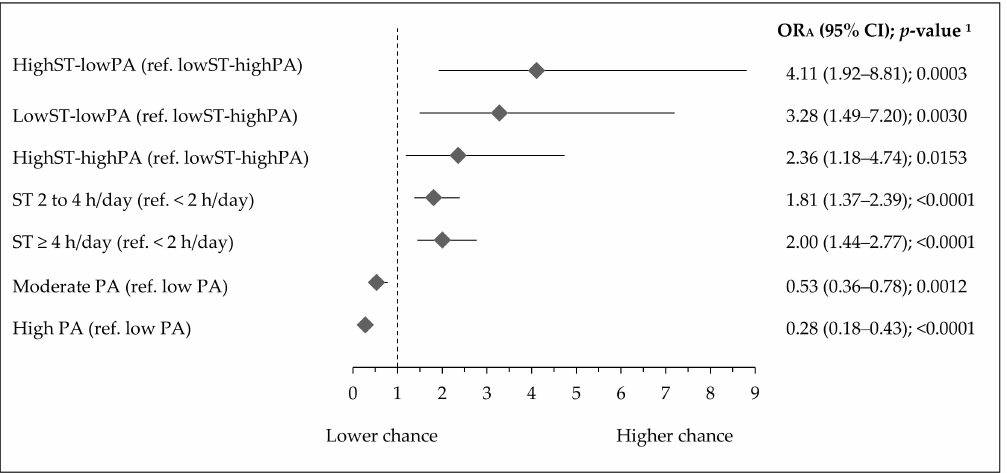
Figure 2. Association of activity–inactivity patterns, ST, and PA with overweight in Polish teenagers (ref. normal weight). Notes: ST—screen time; PA—physical activity; overweight and normal weight identified as gender-age-related-BMI according to international standards [35] as follows: overweight BMI ≥ 25 kg / m 2 , normal weight BMI = 18.5 to 24.9 kg / m 2 ; OR A —odds ratio adjusted for gender, age (years), residence (categorical variable), Family A ffl uence Scale (points), and Nutrition Knowledge Score (points); 95% CI—confidence interval; 1 Wald test significance